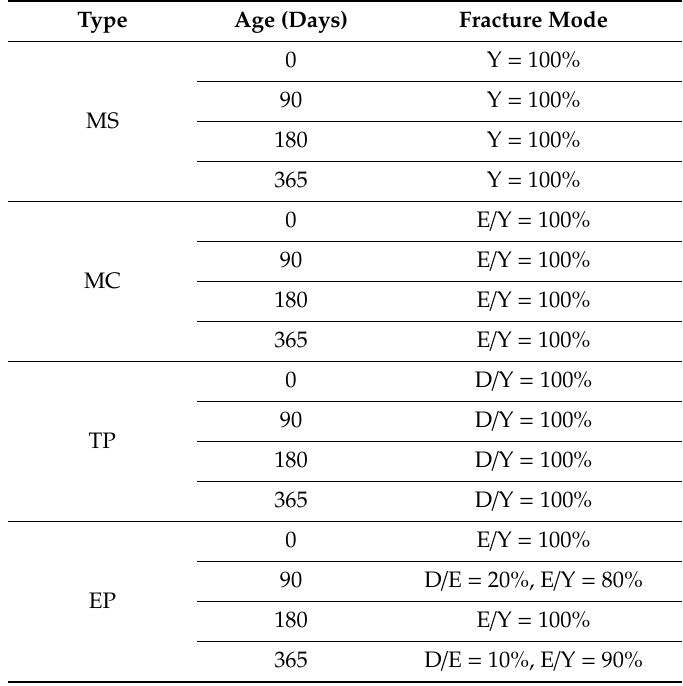
Table 5. Adhesion test results of coating systems exposed to atmosphere zone.